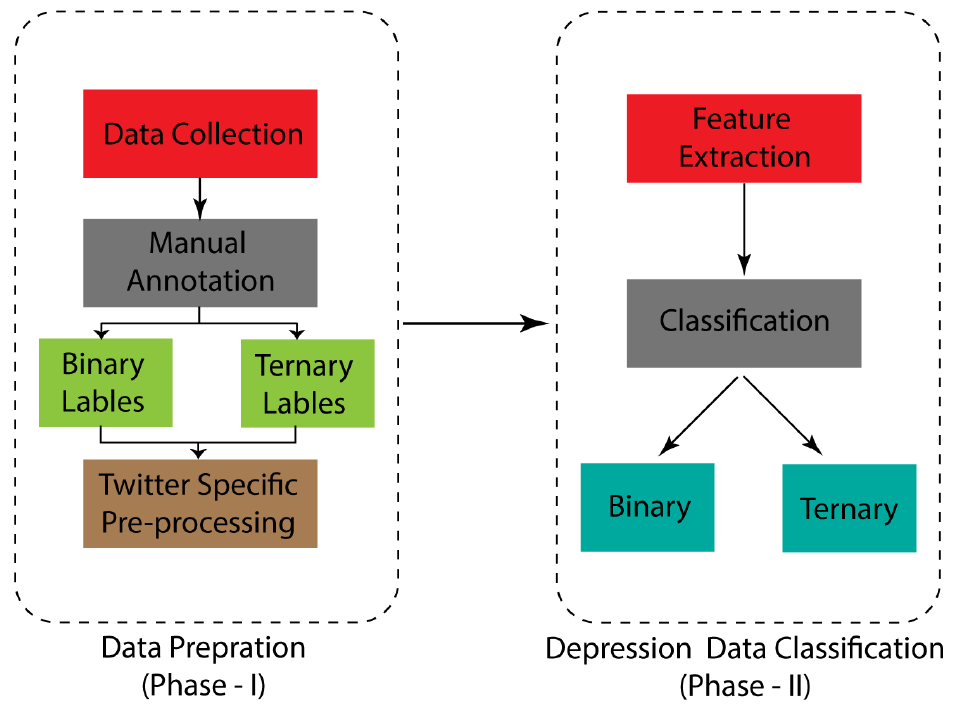
Figure 1. Phases of the depression classification